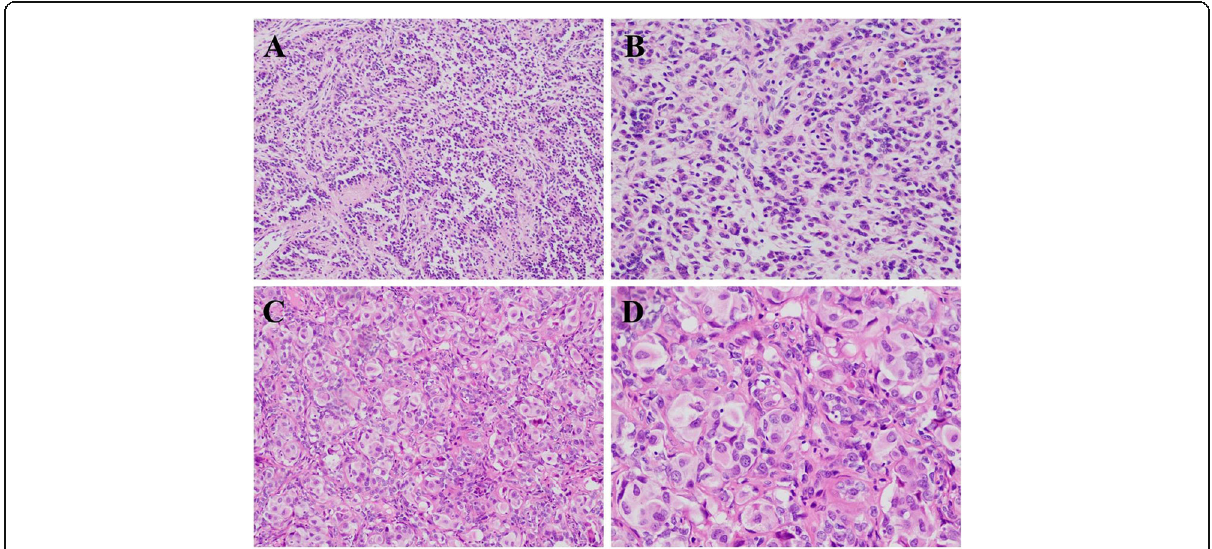
Fig. 1 The representative pictures of UTROSCT. ( a ) intermediate magnification; ( b ) high magnification; ( c , d ) UTROSCT with polygonal cells (Hematoxylin-eosin staining, a , c : × 100, b , d : × 200)